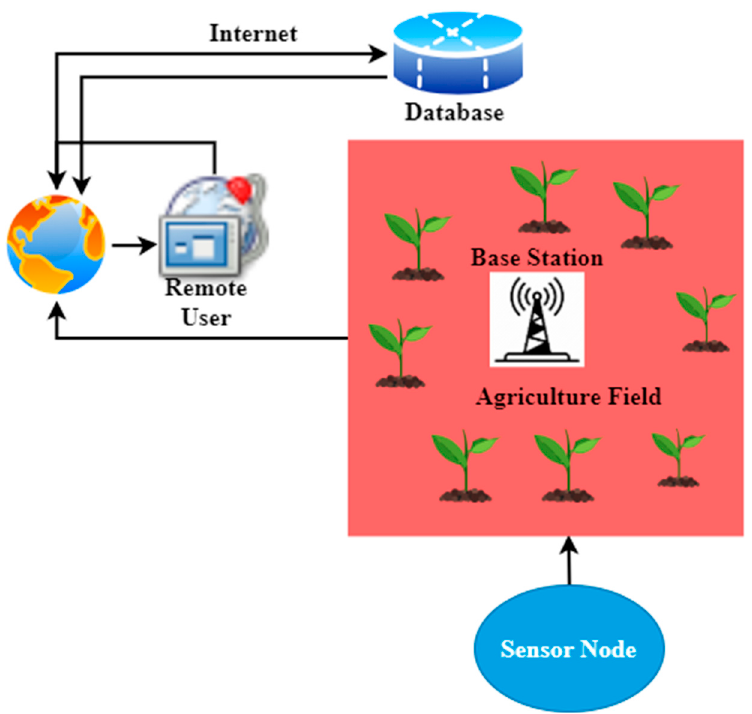
Figure 4. Agricultural field using sensor nodes and database system.